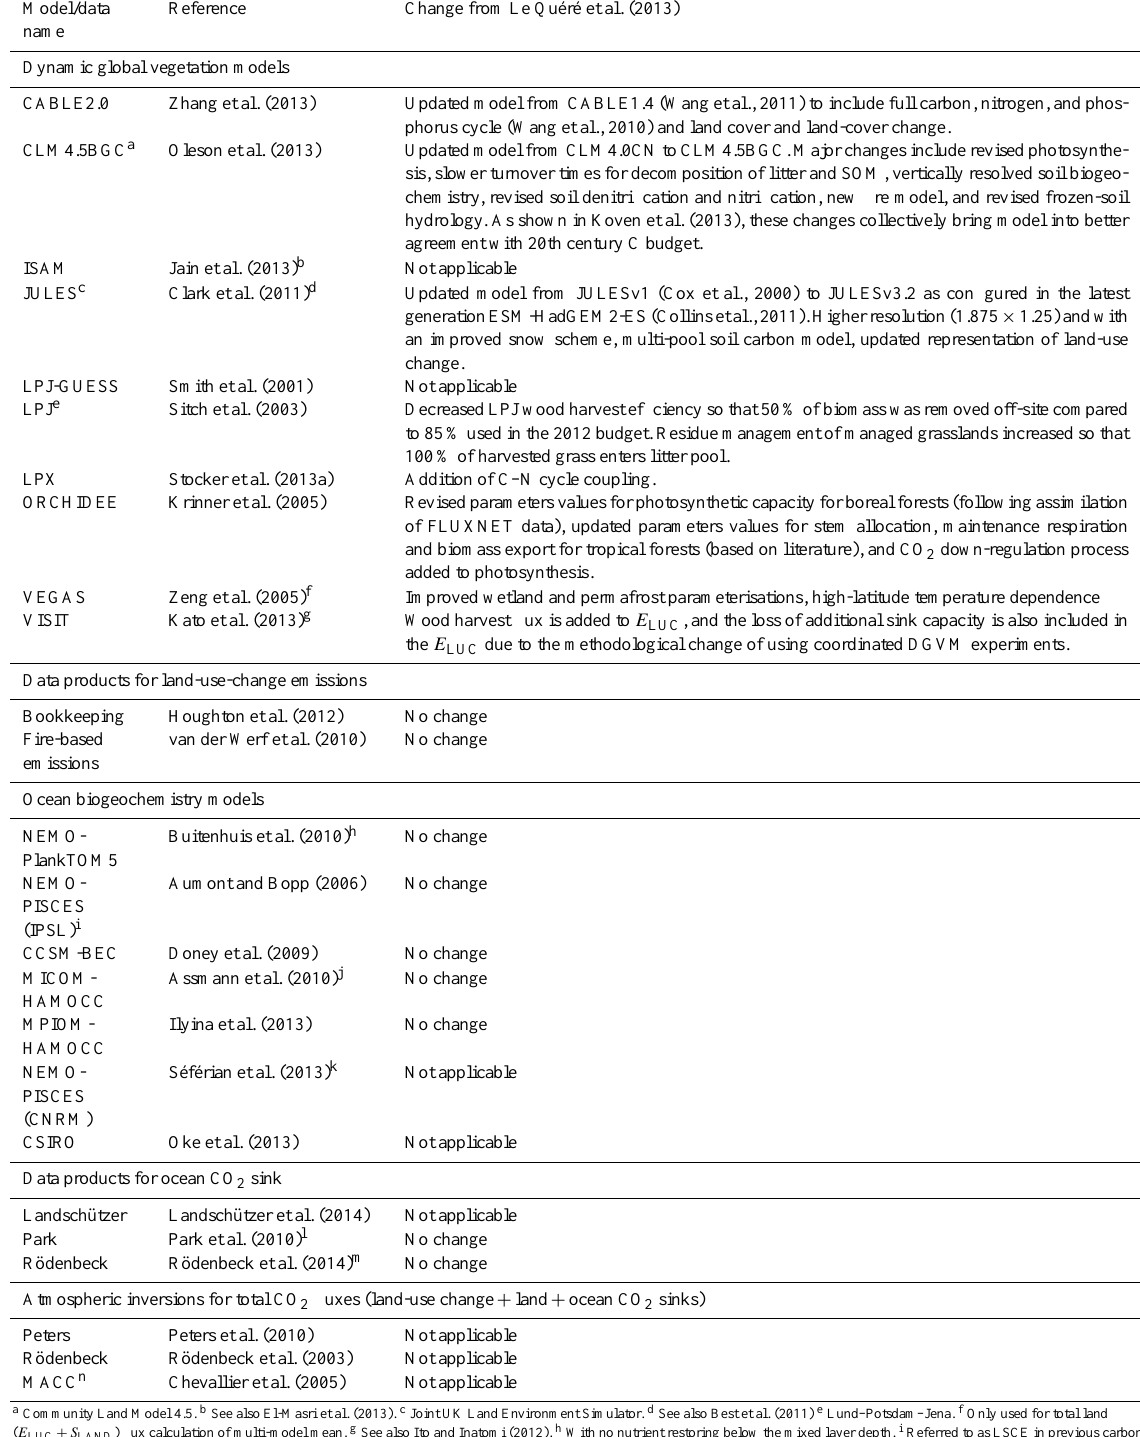
Table 6. References for the process models and data products included in Figs.